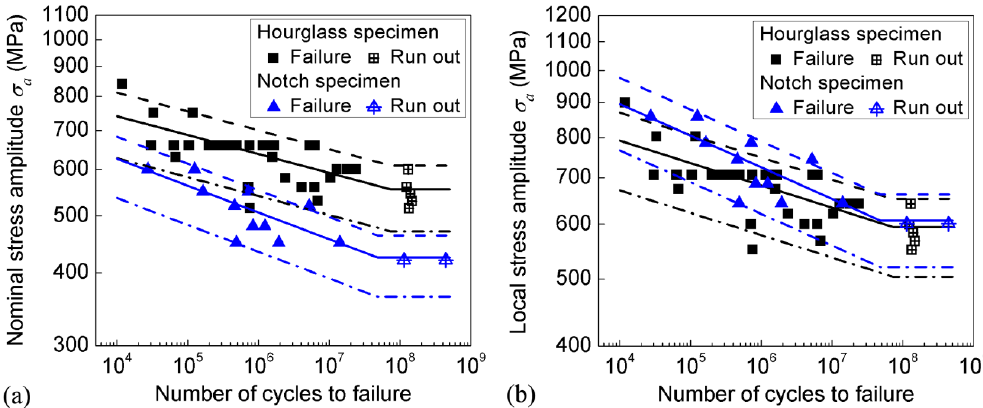
Figure 3. S-N data of hourglass and notch specimens. ( a ) Nominal stress amplitude versus fatigue life; ( b ) Local stress amplitude versus fatigue life, in which the solid curve, dashed curve, and the dot and dash curve denote the predicted S-N curves at 50%, 5% and 95% survival probabilities, respectively. SEM observation indicates that all the hourglass and notch specimens fail from the specimen surface. For both hourglass and notch specimens, single-site crack initiation and multi-site crack initiation are observed at the fracture surface. Figures 4 and 5 show the SEM images of the fracture surface of several hourglass and notch specimens, respectively.